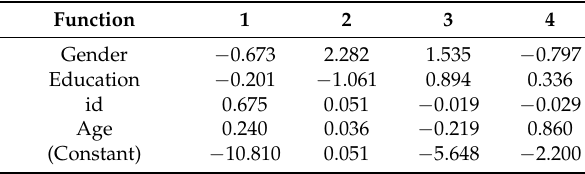
Table A13. Canonical discriminant function coefficients.